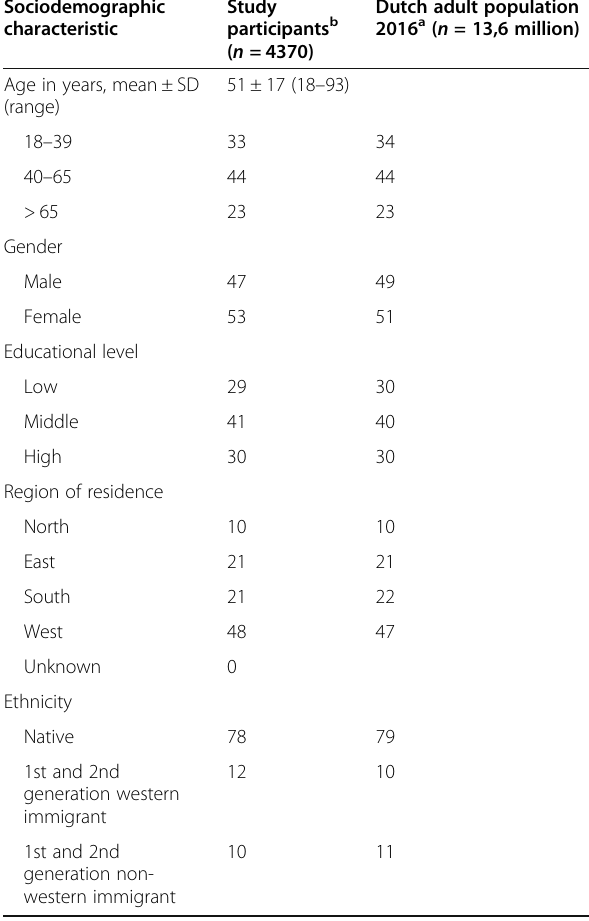
Table 1 Sociodemographic characteristics of participants and the Dutch general